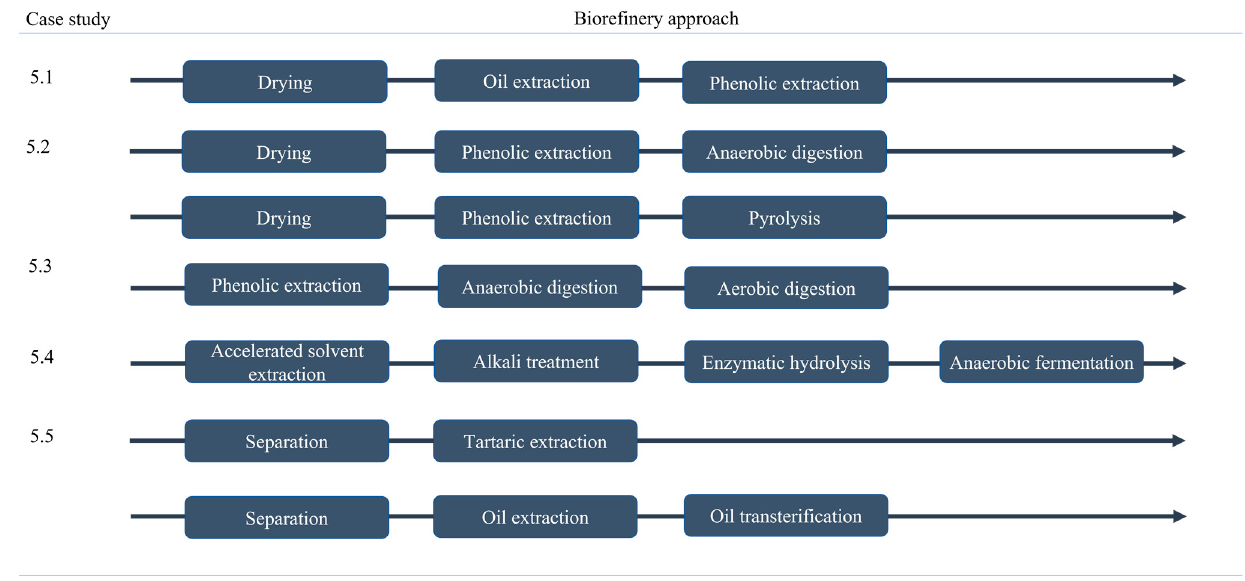
Figure 3. Strategies of biorefinery investigated and presented as case studies in Section 5.1–5.5.